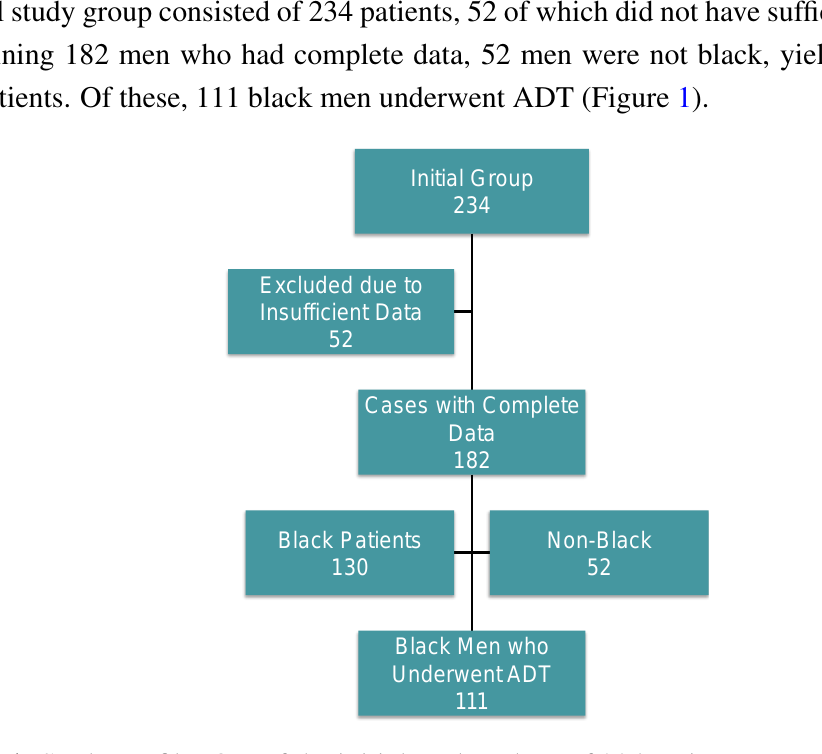
Figure 1. Study profile. Out of the initial study cohort of 234 patients, a total of 182 patients had sufficient data for analysis, of which 130 patients were black and 111 (85.4%) underwent androgen deprivation therapy.